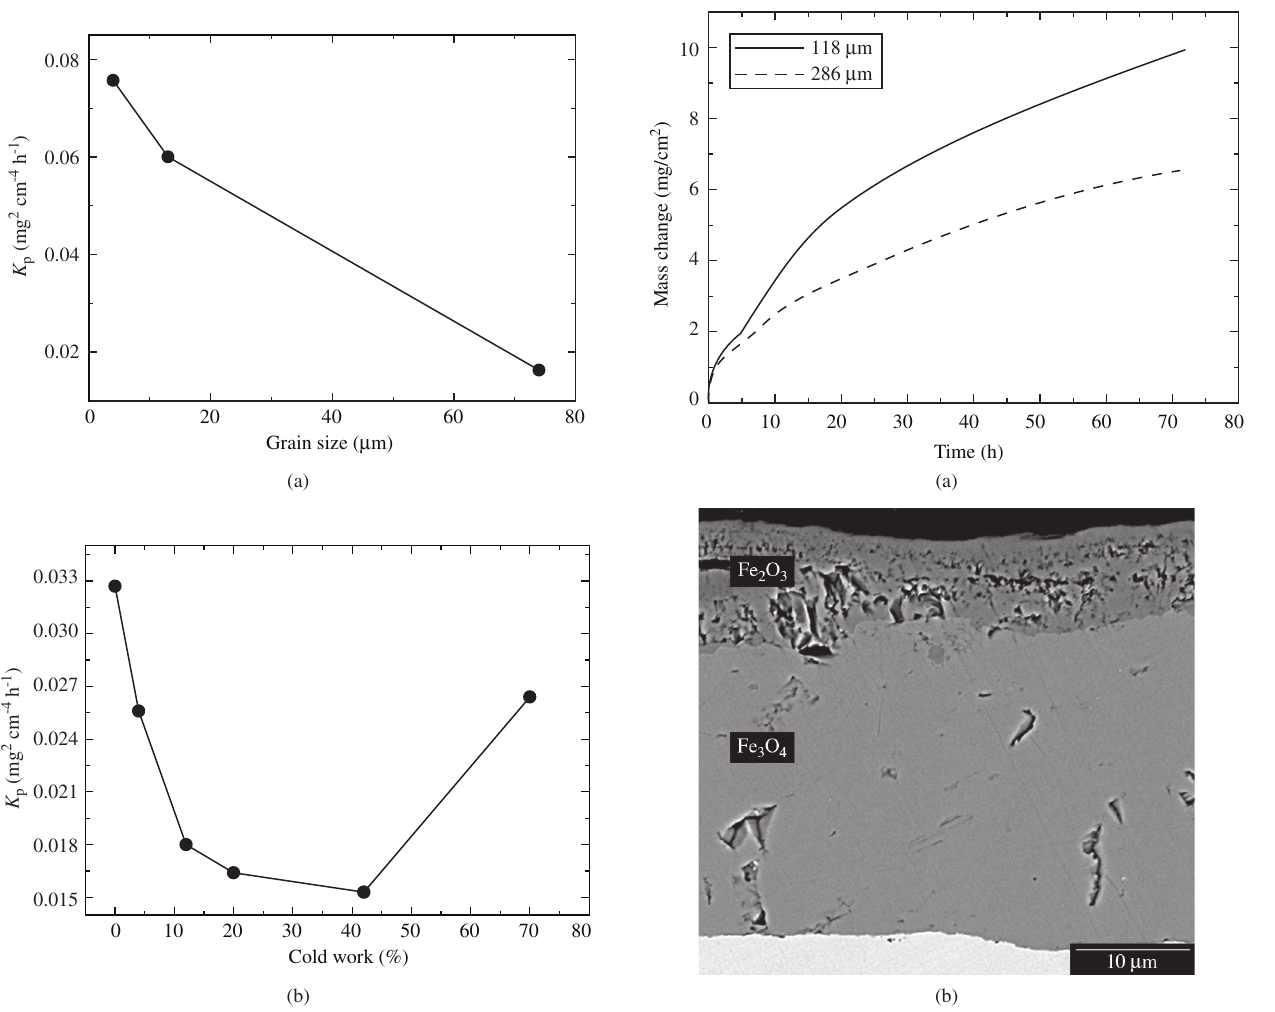
Figure 4. a) Effect of the grain size of the substrate on the oxidation kinetics of the 2.25Cr1Mo oxidized at 550 °C in laboratory air for 72 hours; b) effect